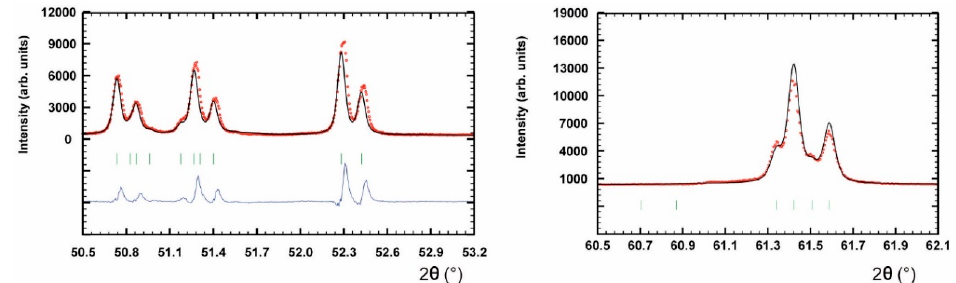
Figure 3. Details of the Rietveld profiles of synthetic thalhammerite showing the weak peak splitting, which cannot be fitted using the tetragonal cell. The observed (circles), calculated (solid), and difference profiles are shown. The vertical bars correspond to Bragg reflections.